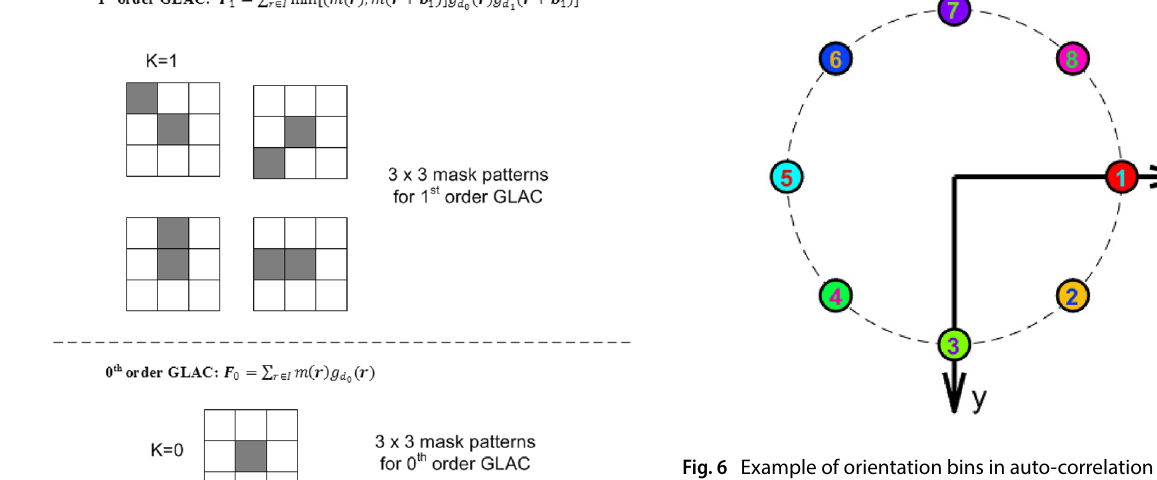
Fig. 6 Example of orientation bins in auto-correlation computation